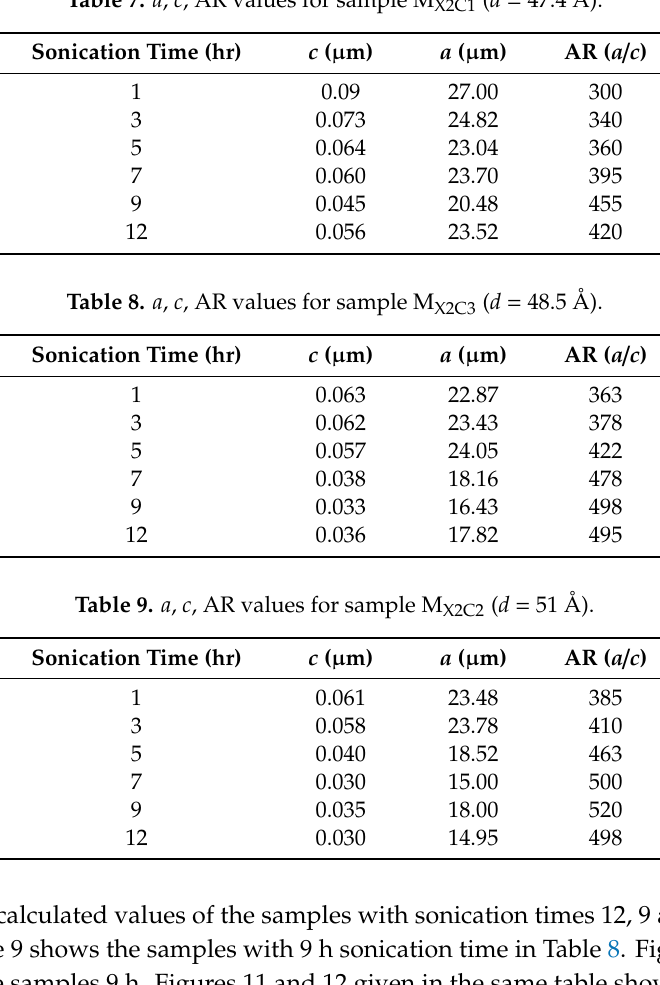
Table 7. a , c , AR values for sample M X2C1 ( d = 47.4 Å).